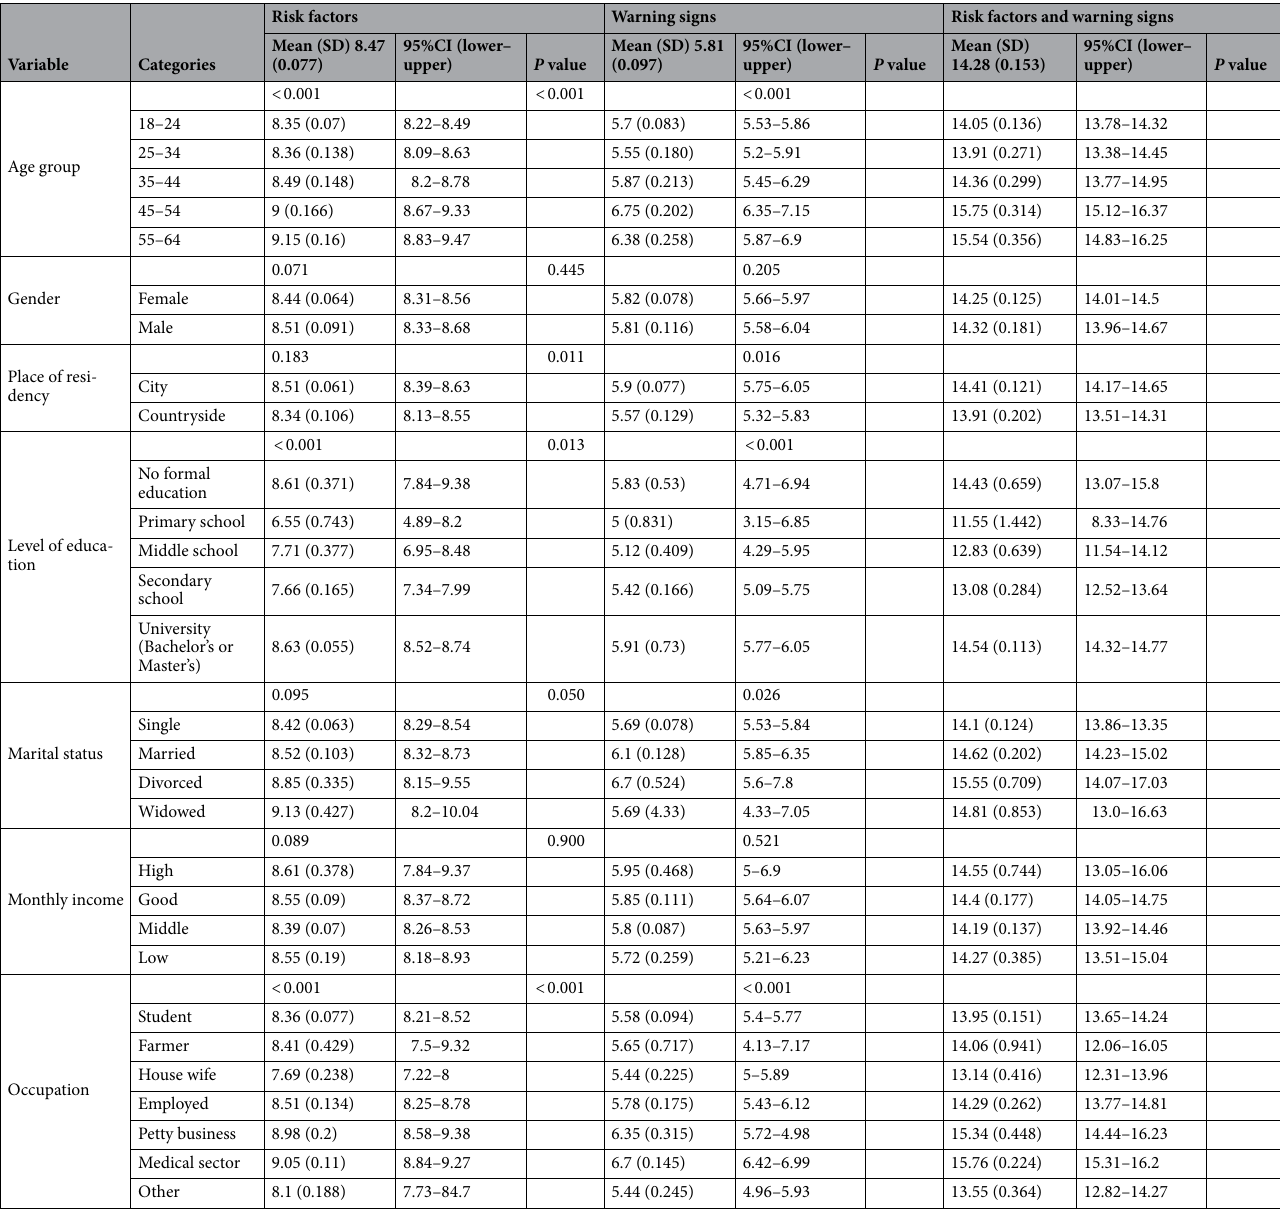
Table 4. The Difference between the sub-groups of knowledge toward risk factors, and warning signs of CVDs among the study